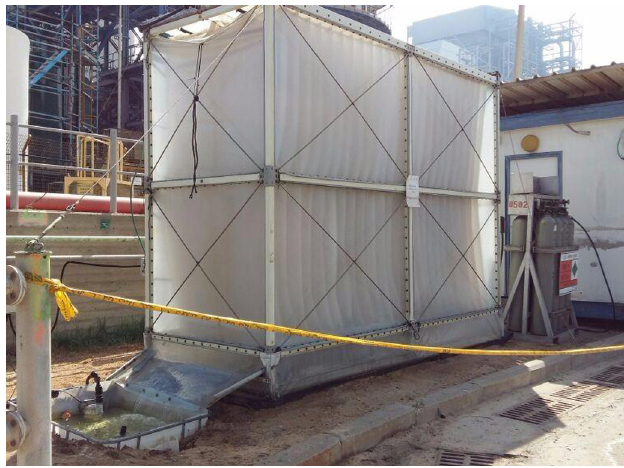
Fig. 2. Picture of the PBR at the Rothenberg coal propelled power station, aimed for reduction in nitrogen compounds and metals in the aquatic solution and for GHGs reduction from the fl ue gas